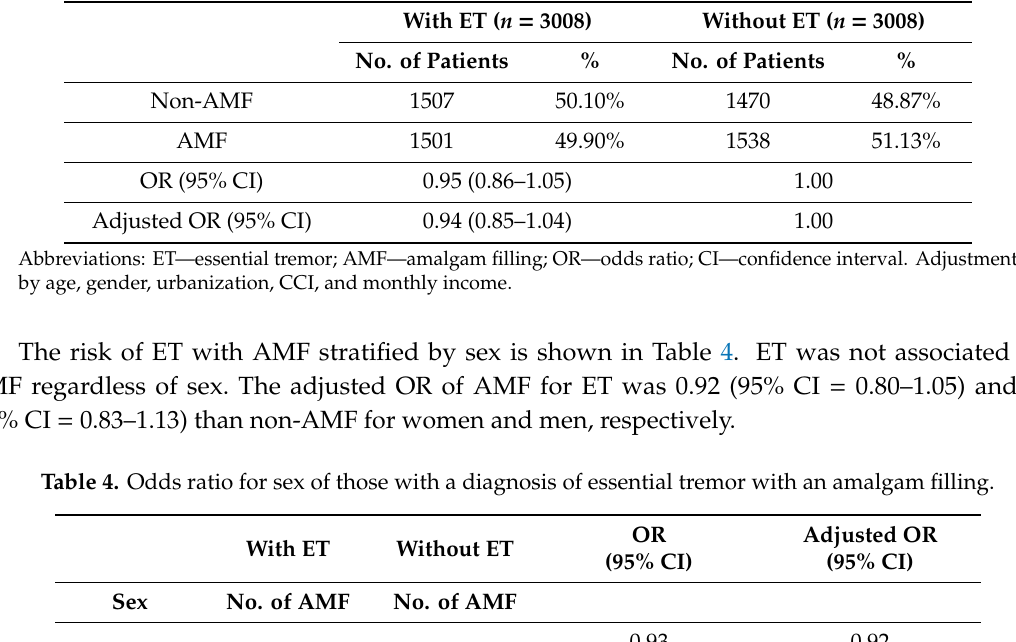
Table 3. Odds ratio for amalgam filling of those with a diagnosis of essential tremor. With ET ( n = 3008) Without ET ( n = 3008) No. of Patients % No. of Patients % Non-AMF 1507 50.10% 1470 48.87% 1501 49.90% 1538 51.13%